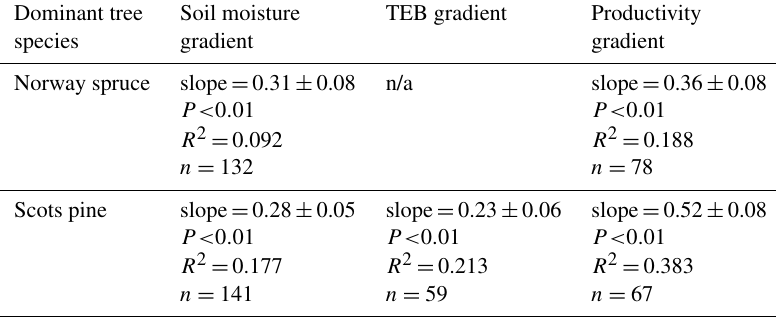
Table 5. Evaluation of adjusted nutrient availability metric 2 for selected nutrient availability gradients in Sweden (Fig. S2). Statistics indicate the relationship between productivity (mean annual increment – m 3 ha − 1 yr − 1 ) and the metric. For (near) significant variables (i.e. P< 0 . 10), parameter estimates ± s.e.m. and the proportion of variation explained ( R 2 ) are given. For Norway spruce, no TEB gradient without substantial variation in climate was found, so that only for Scots pine was there a gradient in TEB. Abbreviations: C:N: soil carbon- to-nitrogen ratio; TEB: total exchangeable bases. Error bars represent the